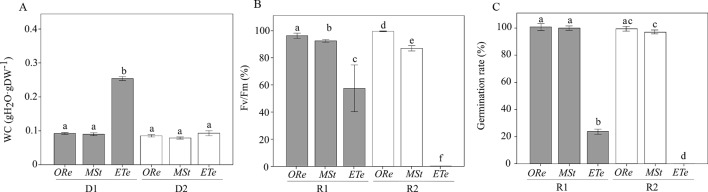
Water content (WC) (A), percentage of recovery of Fv/Fm (B), and percentage of germination (C) relative to the respective control values after first rehydration (R1) (gray bars) and second rehydration (R2) (white bars) at 10% RH in darkness in the spores of the three studied ferns. Control values of Fv/Fm in nontreated spores were obtained after 24 h of hydration in darkness. Control values of germination in nontreated spores were obtained 10 days after sowing on Dyer medium. Each bar represents the mean ± SE (n = 4). Different letters indicate significant differences among species and dehydration–rehydration (D–H) cycles (P < 0.05).